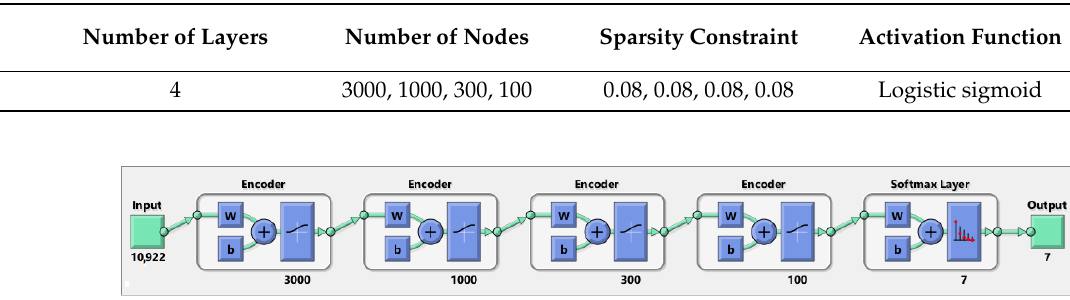
Figure 12. The final architecture of the SSA-DNN model.